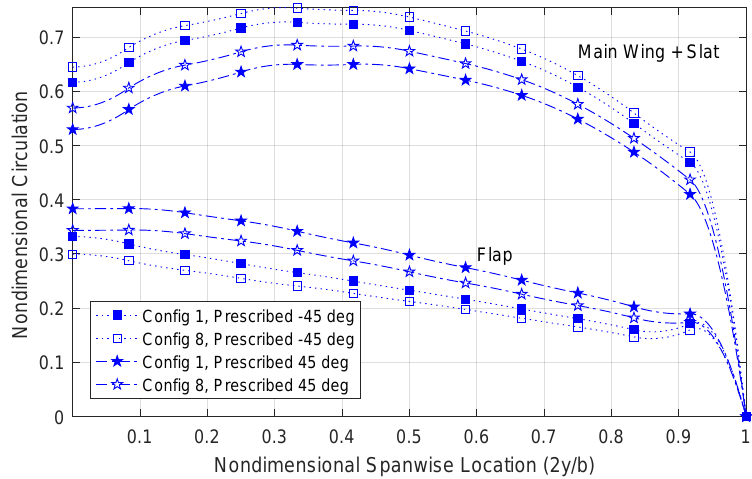
Figure 18. Spanwise circulation predictions for the NASA Trap Wing at two configurations representing a flap angle change, C L = 2.0.